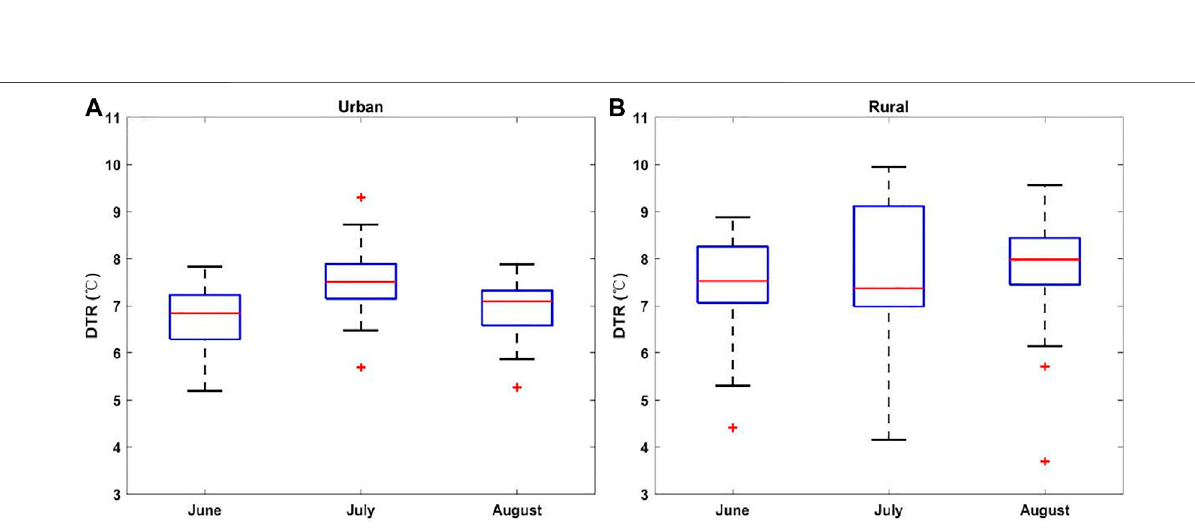
Frontiers in Environmental Science |